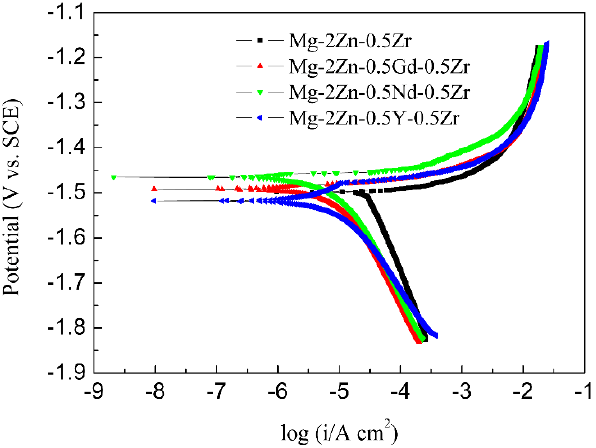
Figure 9. Potentiodynamic polarization curves of the alloys in Hank’s solution at 37 °C . Table 6. Tafel fitting results of the potentiodynamic polarization curves of the alloys. Samples E (V. vs. SCE)